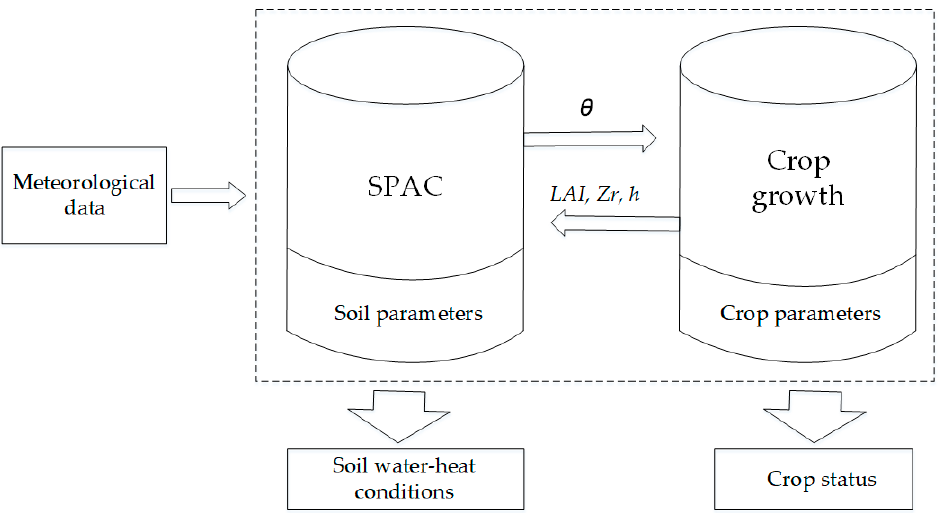
Figure 1. Coupling structure of the CropSPAC model. θ is the soil water content; Zr is the root distribution; and h is the plant height.